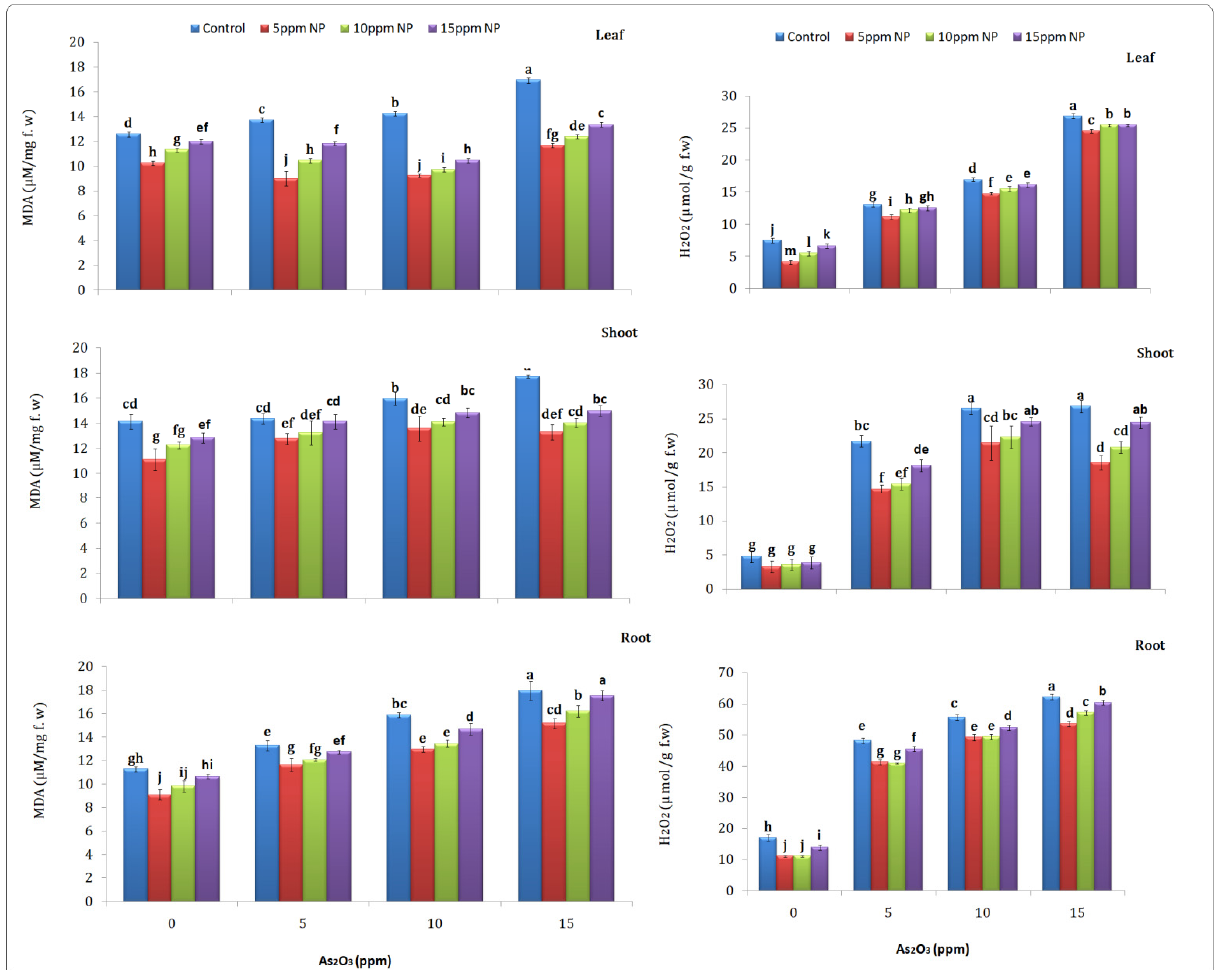
Figure 6. Effect of Bacillus subtilis synthesized iron oxide nanoparticles on MDA and H 2 O 2 content of rice ( Oryza sativa L.) in arsenic contaminated water. Different letters indicate significant differences ( p < 0.05) between treatments.